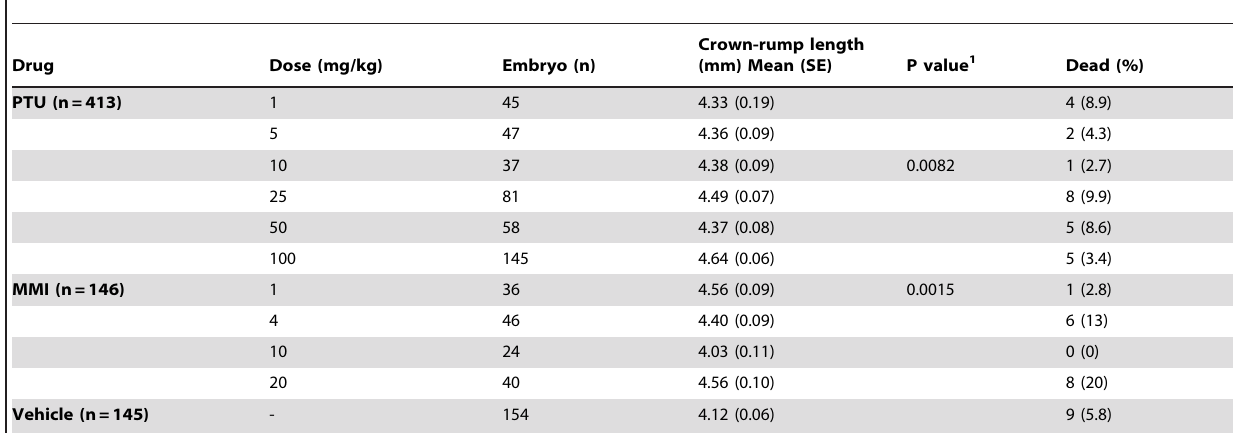
Table 1. Crown-rump length and viability of E10.5 murine embryos.